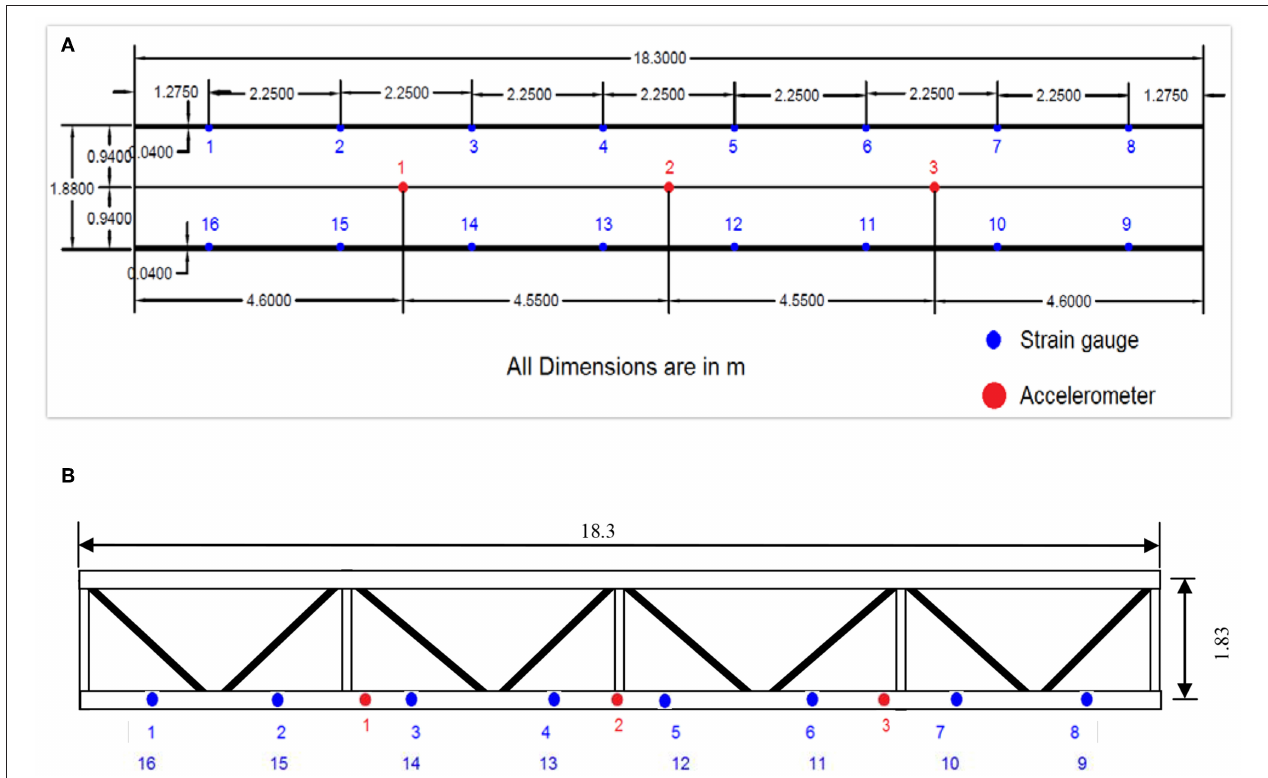
FIGURE 2 | Ponneri railway bridge instrumentation. (A) Elevation. (B) Plan view (sensors are on the exterior face of the outer girder).